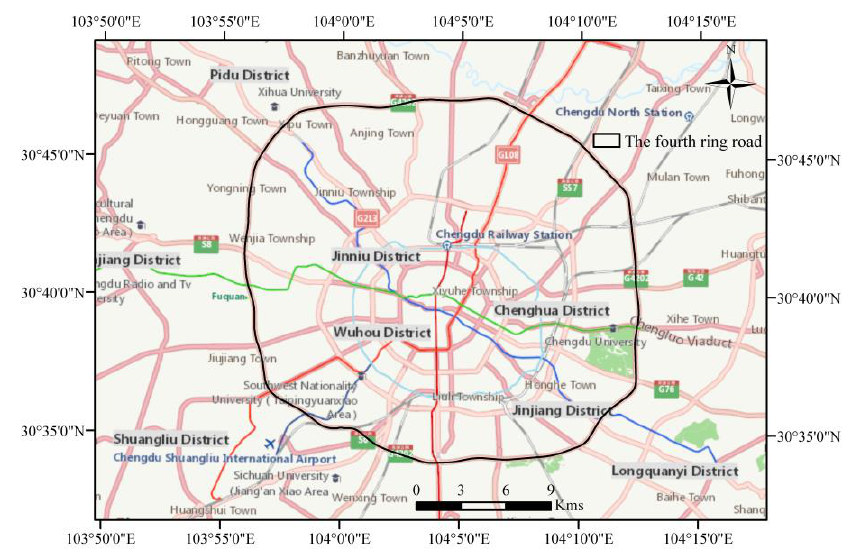
Figure 1. The study area